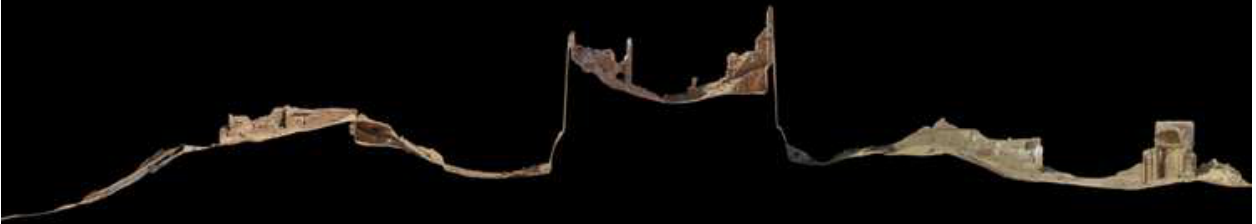
Figure 9. Northern Prospect of the Fortified Settlement (slightly transparent).